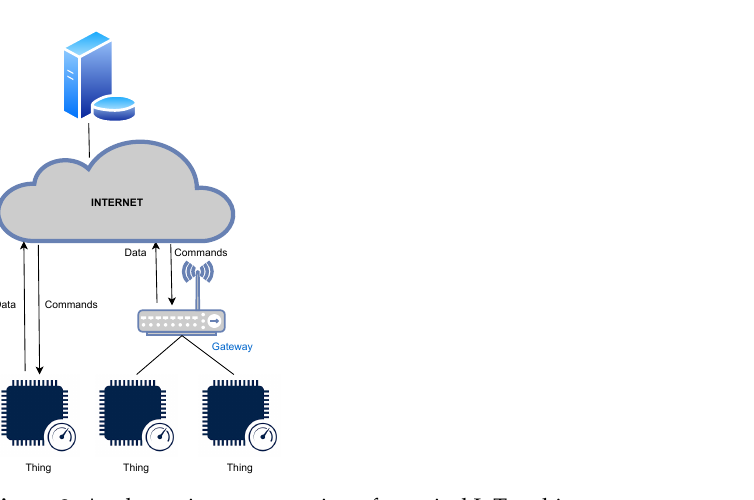
Figure 2. A schematic representation of a typical IoT